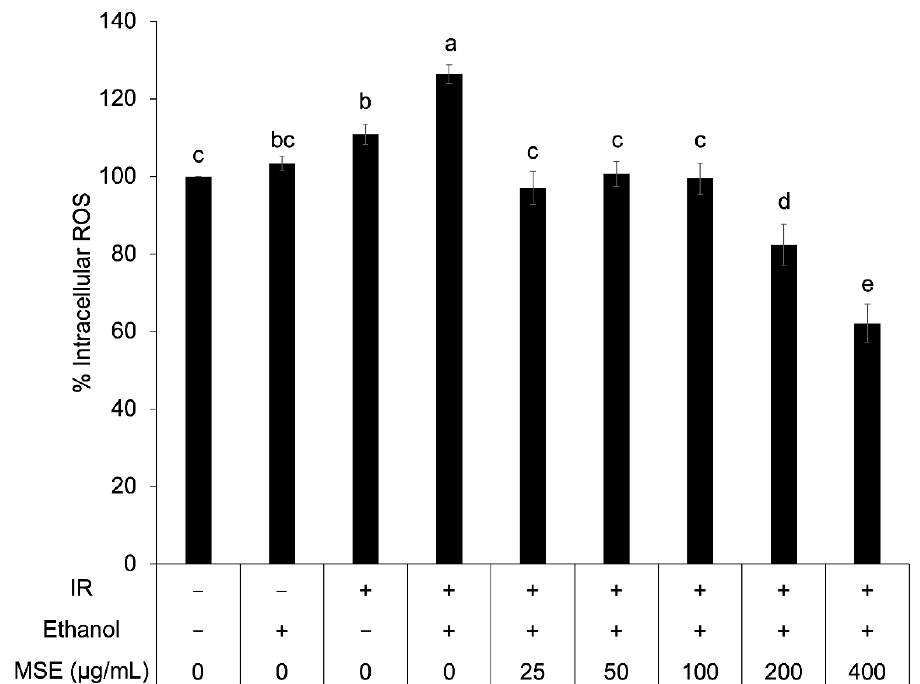
Figure 5. Cellular glucose uptake in the control and insulin-resistant cells with and without mung bean seed coat extract (MSE) treatment. Statistical analyses were performed using Tukey’s posthoc test and one-way analysis of variance (ANOVA). Values are expressed as the mean ± standard deviation, SD ( n = 3). Different letters ( a – e ) indicate statistical differences ( p < 0.05). IR: insulin-resistant HepG2 cells.